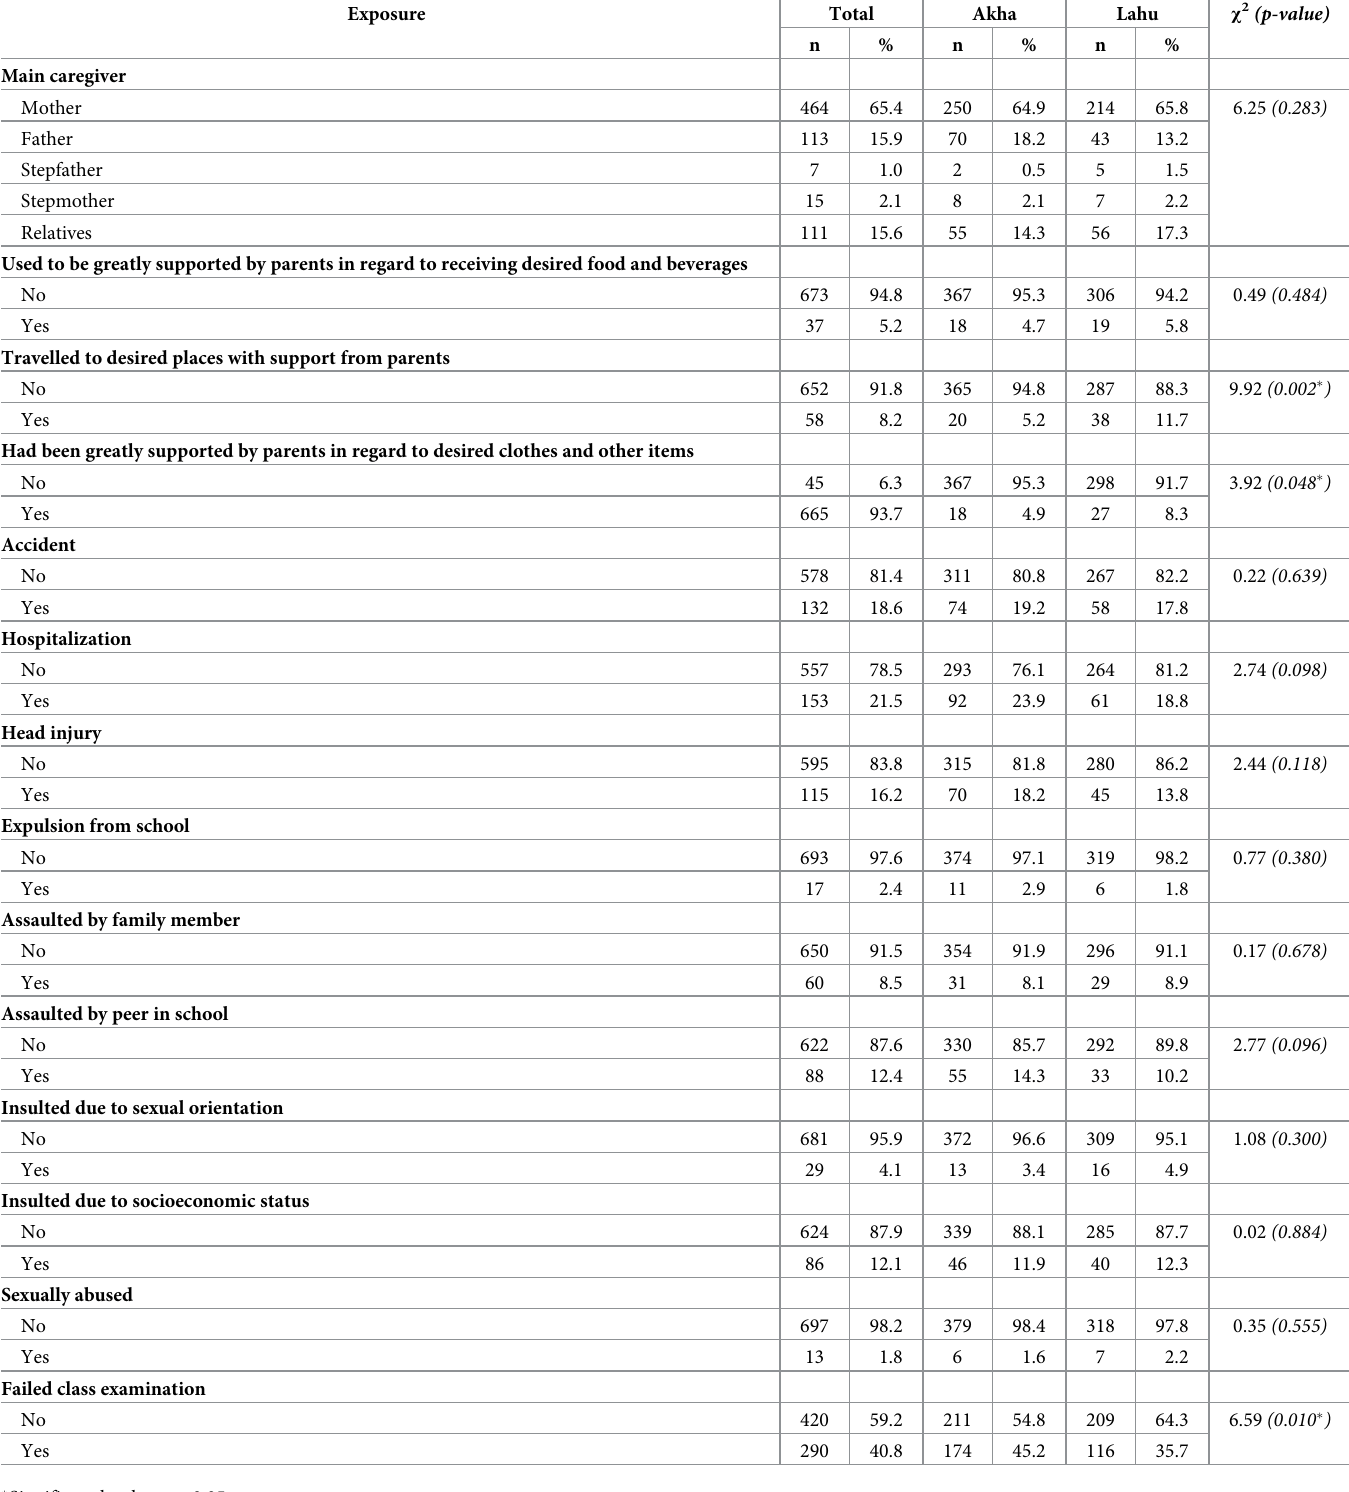
Table 4. Potential exposures relevant to MA use while aged 6–14 years.